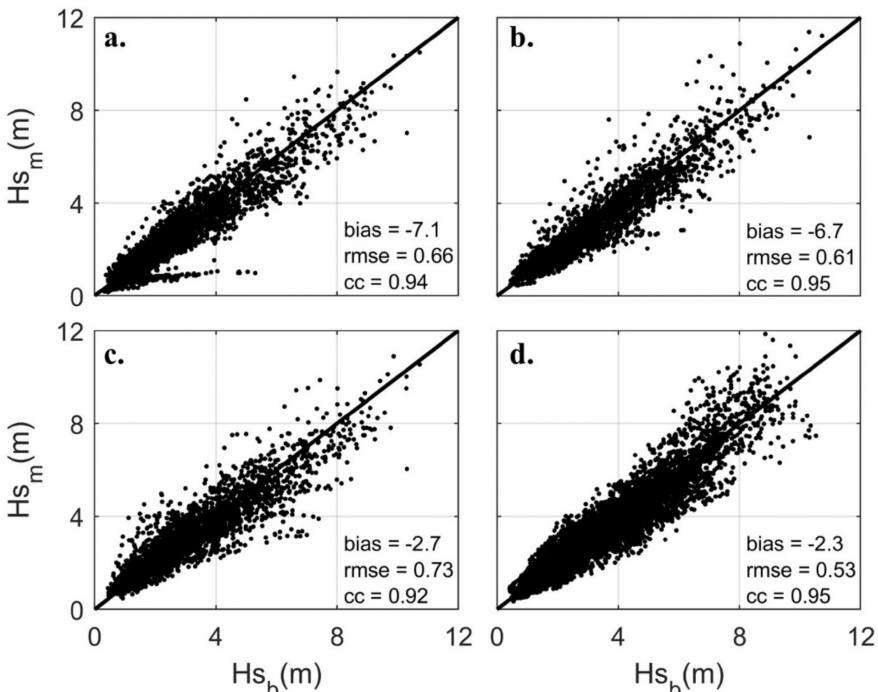
Figure 2. Buoy-model Hs comparison plots for ( a ) NCEP, ( b ) IFREMER, ( c ) ECMWF and ( d ) WIS wave models for all six hurricanes at all buoy locations. ( a – c ) Wave models have a 3- h temporal resolution; ( d ) 1- h temporal resolution. Error statistics for each model is provided in each